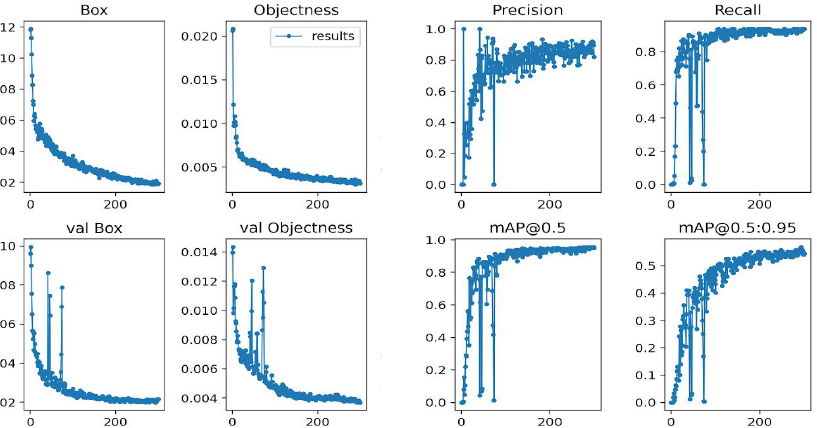
Figure 3. Object detection network initially trained with 851 data points. The dataset was labeled with one target label. The network was stable after 200 epochs of training, as shown in the precision and recall plots.